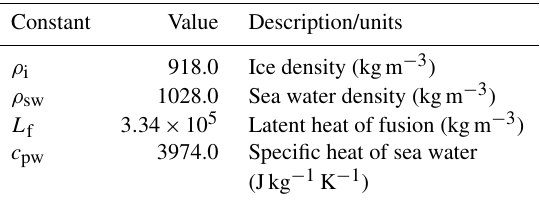
Table 1. Physical constants used in the quadratic melt parameteri-